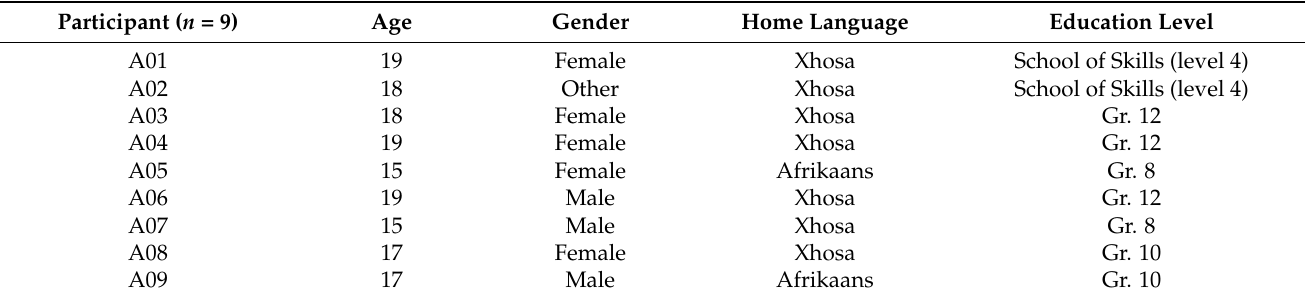
Table 2. Participant